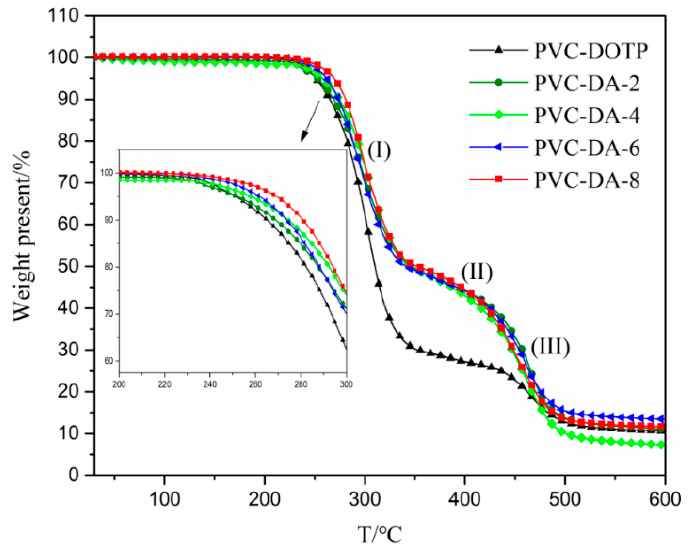
Figure 8. TGA curves of PVC ‐ DA ‐ 2n (2n = 2, 4, 6, and 8) and PVC ‐ DOTP.